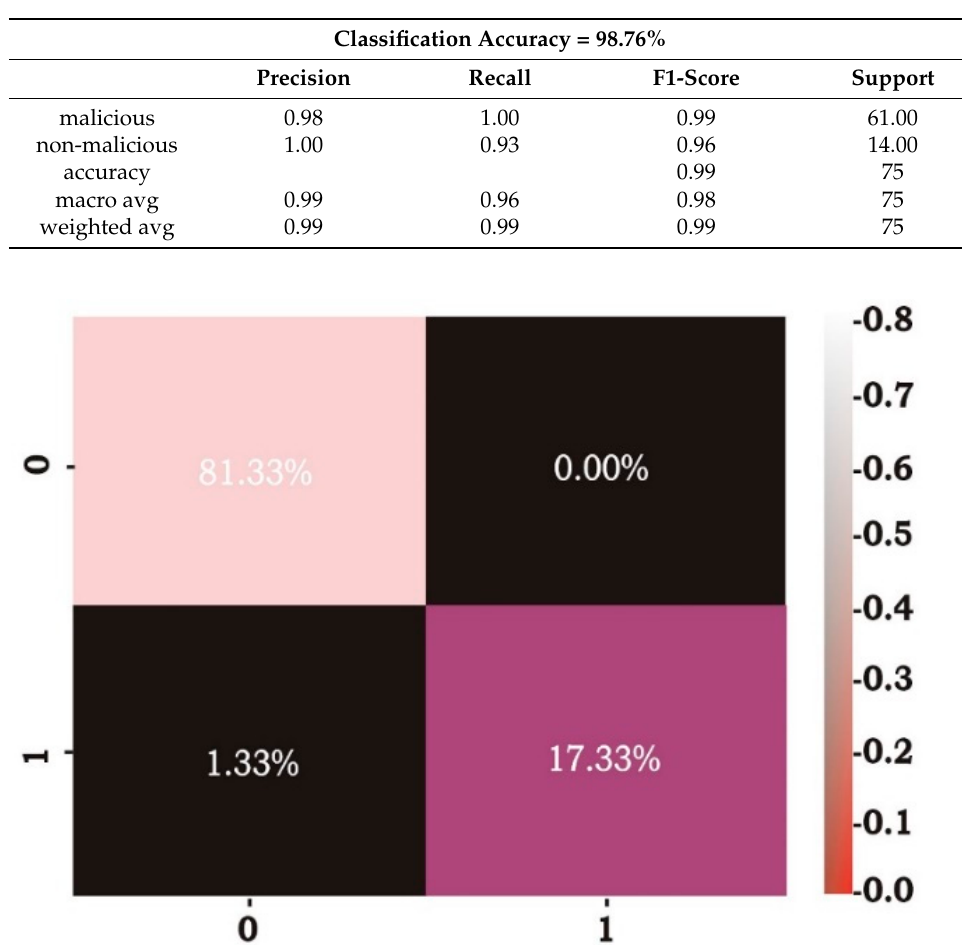
Table A2. DT classifier.